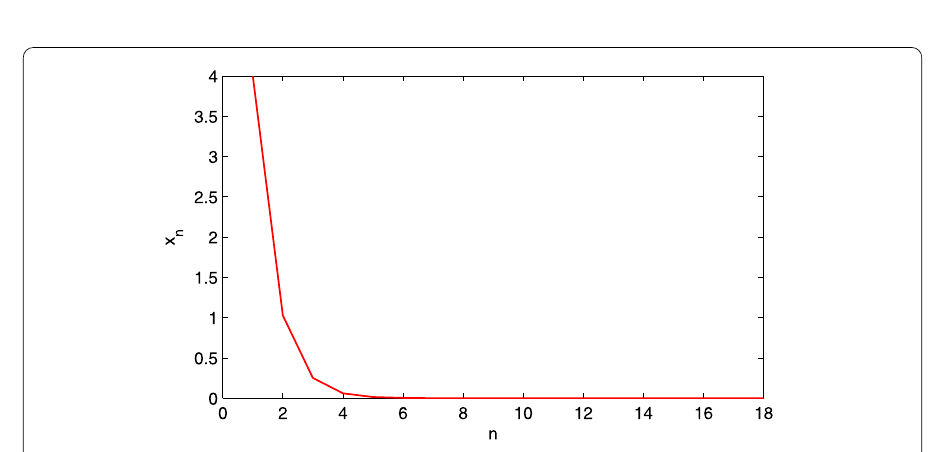
Figure 2 The convergence of { x n } with initial x 1 =